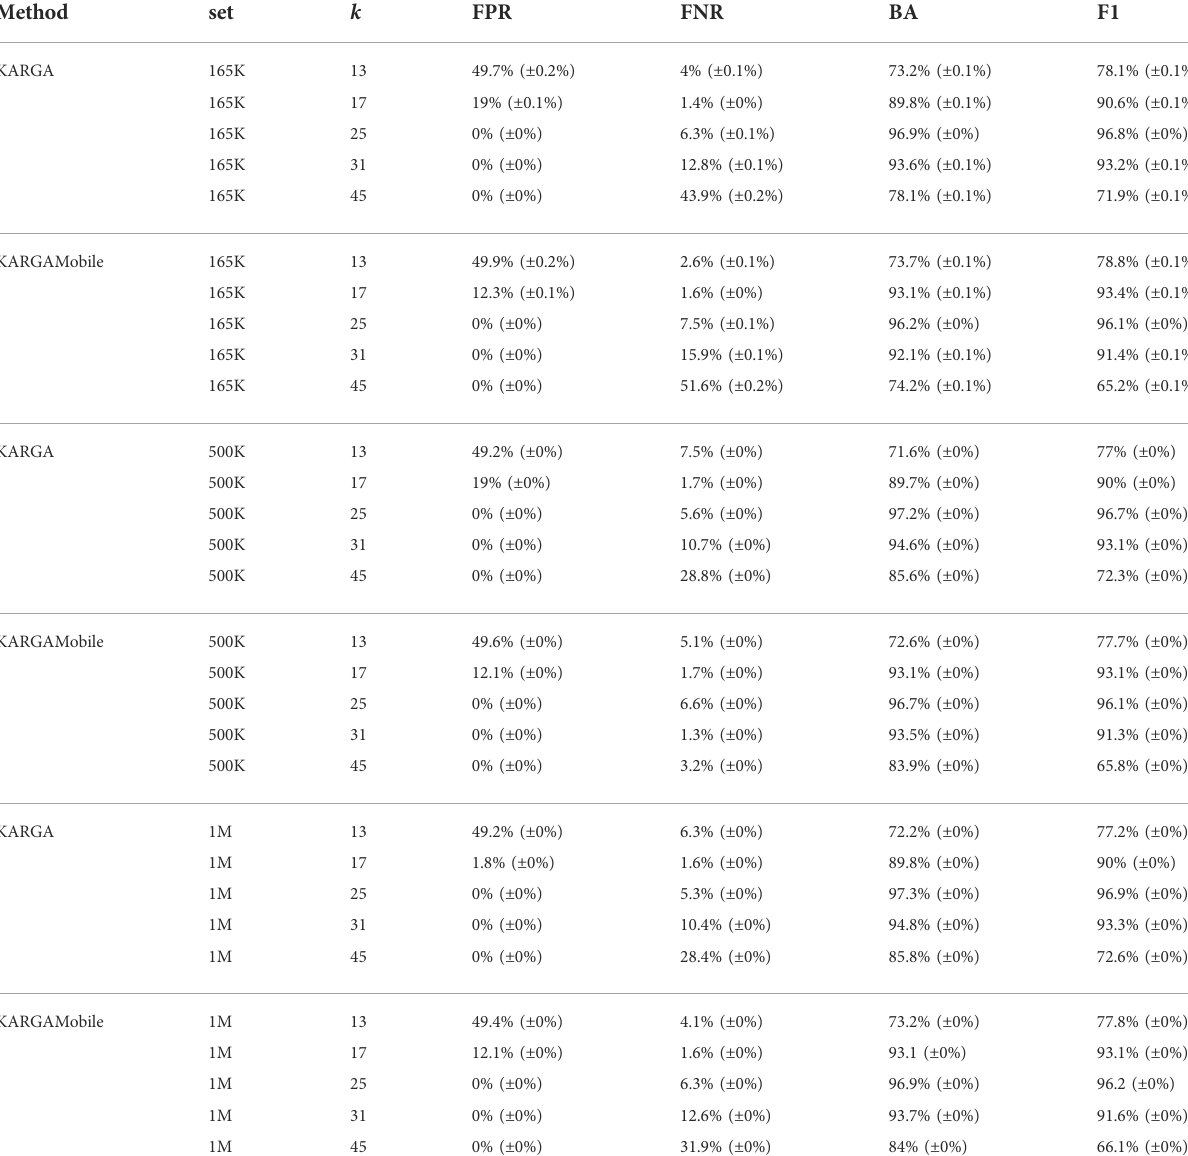
Table 1. From the validation results, the optimal value of k was 25 for both KARGAMobile and KARGA: on the largest dataset, the f 1 -measure was 96.9% for KARGA and 96.2% for KARGAMobile, the balanced accuracy was 97.3% and 96.9%, the false negative rate was 5.4% and 6.3%, with zero false positive rate. Of note, the k value is higher than the usual KARGA (non- mobile version) default. Two contrasting factors in fl uence the optimal value: the read length drives the value up, with Nanopore reads longer than Illumina ones; and the error rate drives the